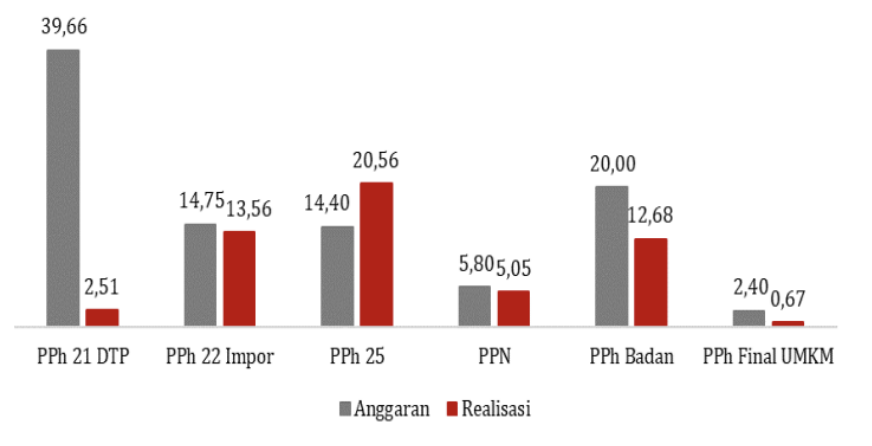
Figure 1. Realization of Tax Incentives in the Economic Recovery Program 2020 (IDR trillion)